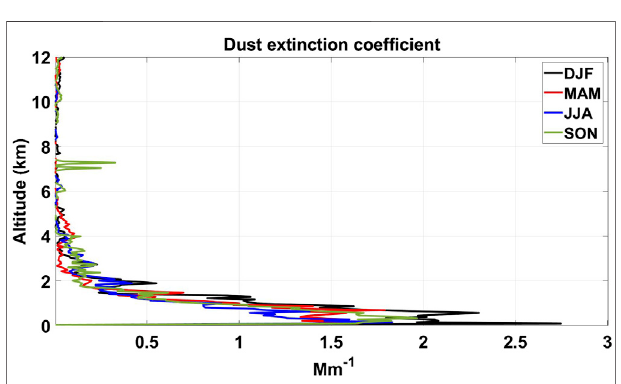
FIGURE 3 | Seasonal mean dust extinction coef fi cient pro fi les from CALIPSO over the period 2007 – 2020, obtained from CALIPSO.